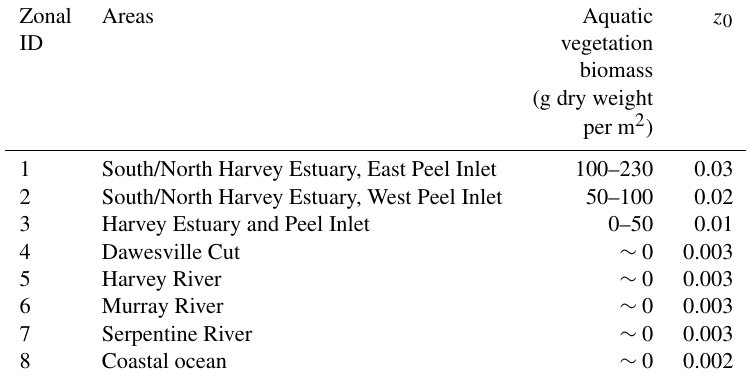
Table 2. Zonal characteristics and roughness length setting ( z 0 ) in the model